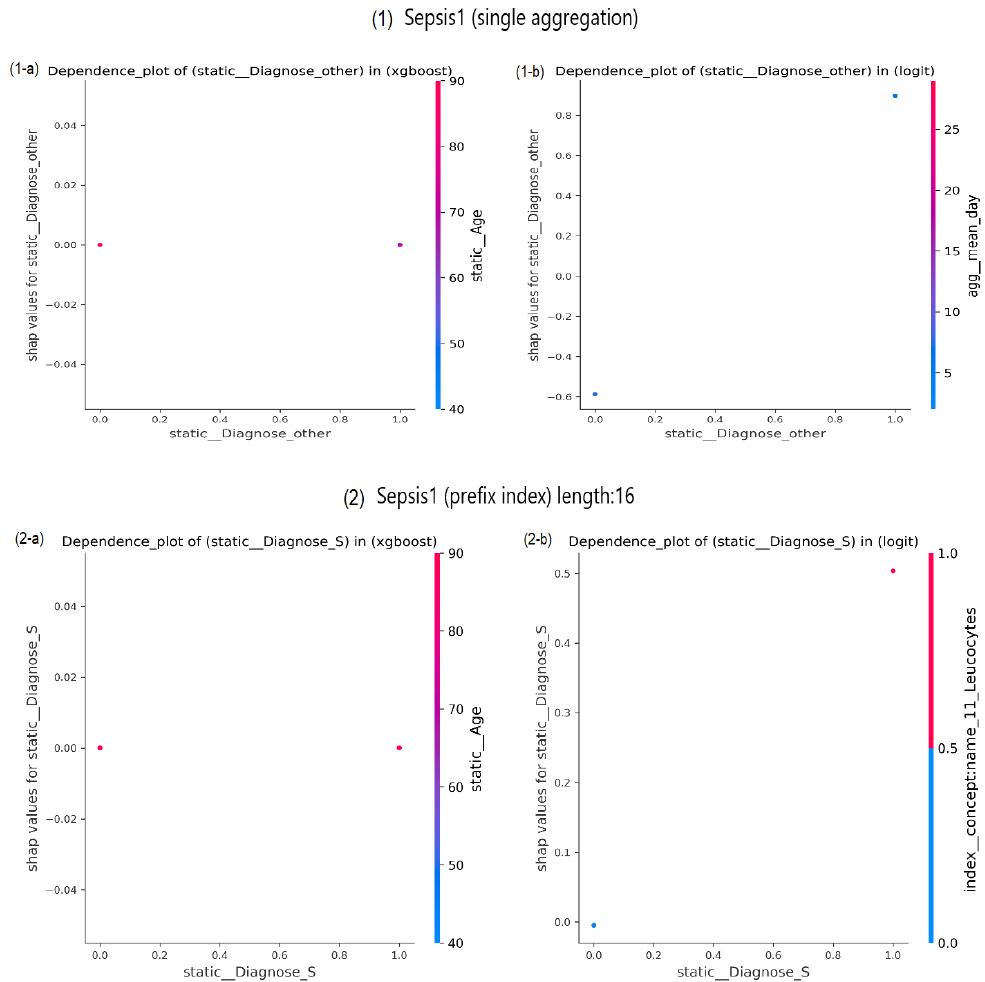
Figure 7. SHAP Dependence plots of Sepsis1 event log.